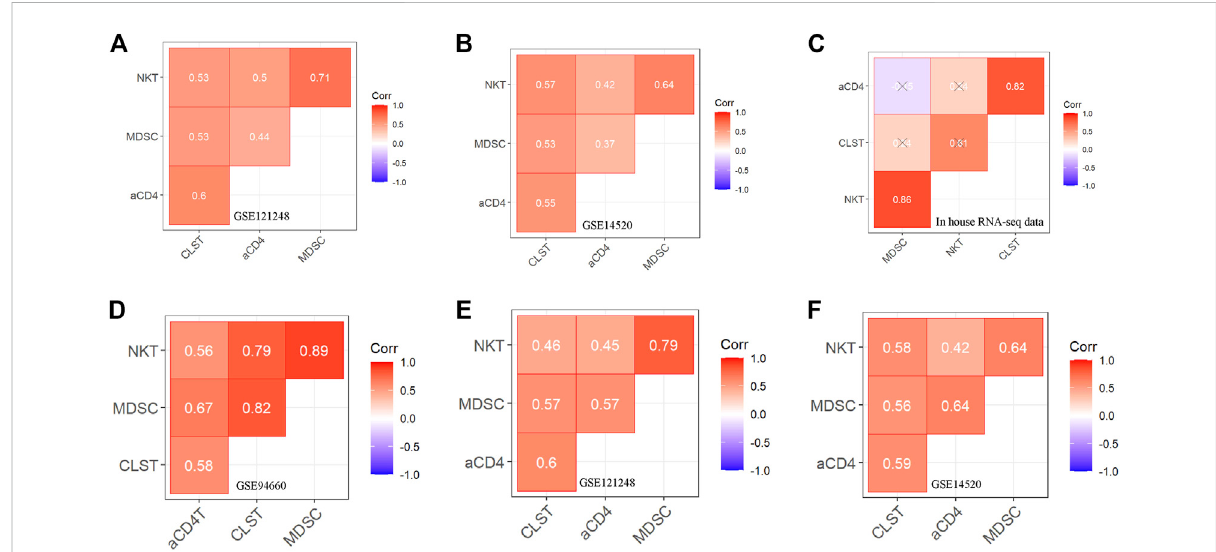
FIGURE 3 Correlation between CLST and LILs in tumor tissues of patients with HBV-HCC (A – C) Pearson correlation analysis showing co-enrichment among CLST, aCD4, NKT, and MDSC in liver tissues of GSE121248, GSE14520, and our in-house RNA-seq data. (D – F) Pearson correlation analysis showing co-enrichment among CLST, aCD4, NKT, and MDSC signals in liver tumor tissues of three independent GSE